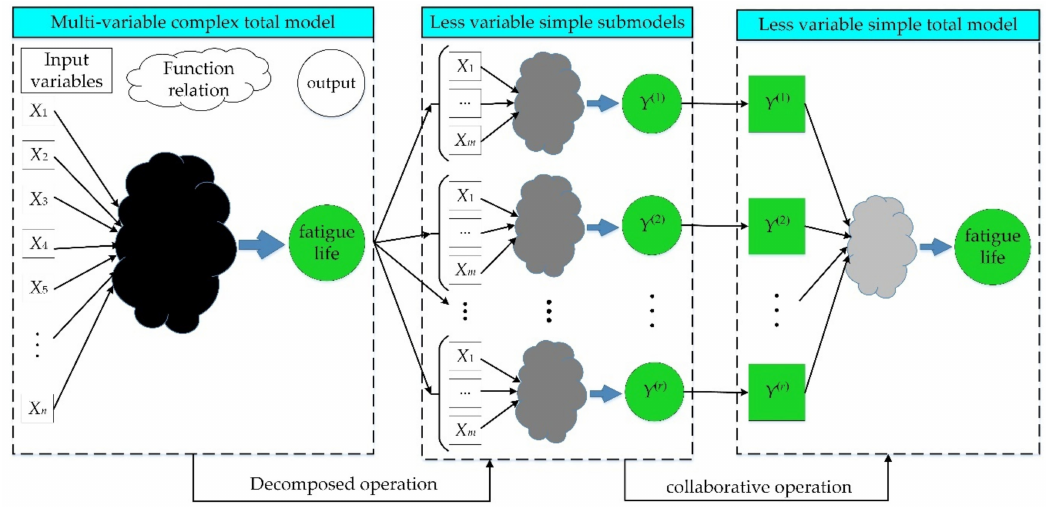
Figure 5. Modeling procedure of the presented decomposed collaborative intelligent Kriging model